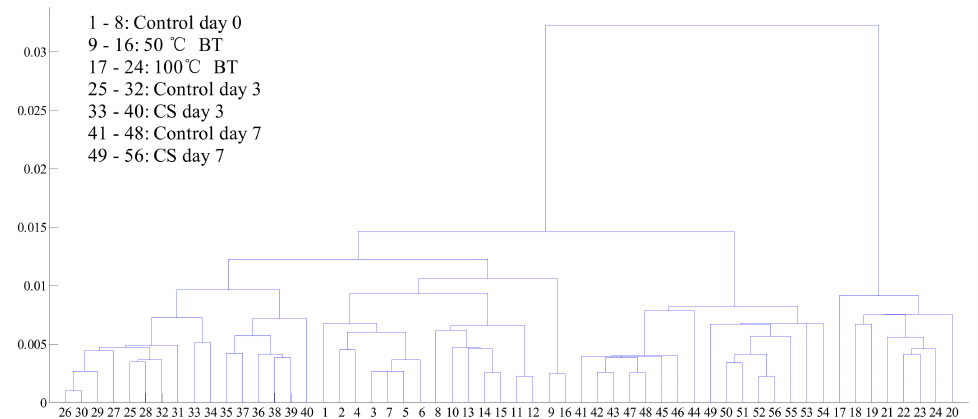
Figure 5. Cluster tree diagram of tomatoes with different postharvest handling treatments.